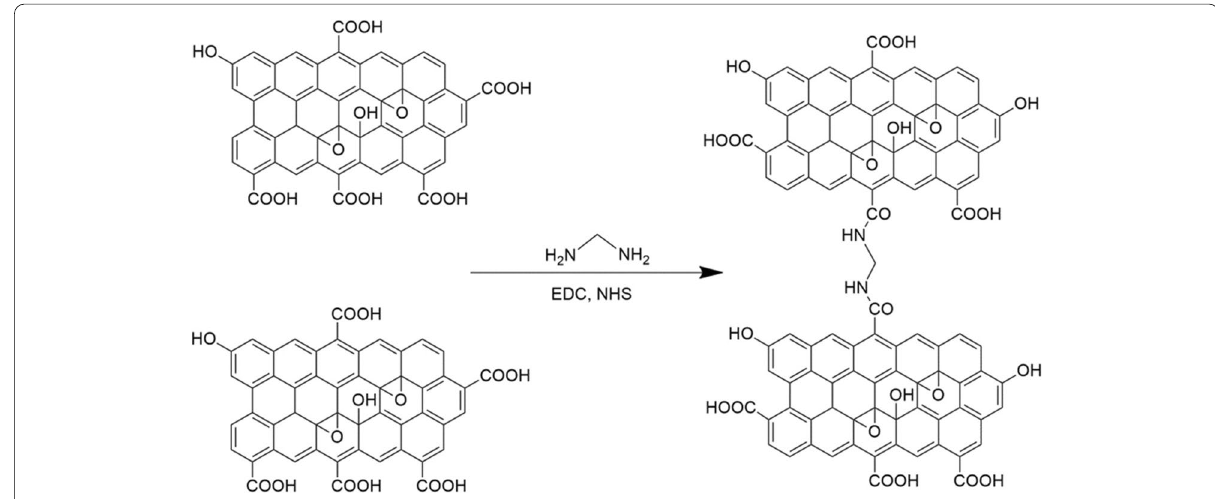
Fig. 2 Synthesis route of chemically crosslinked GO membrane